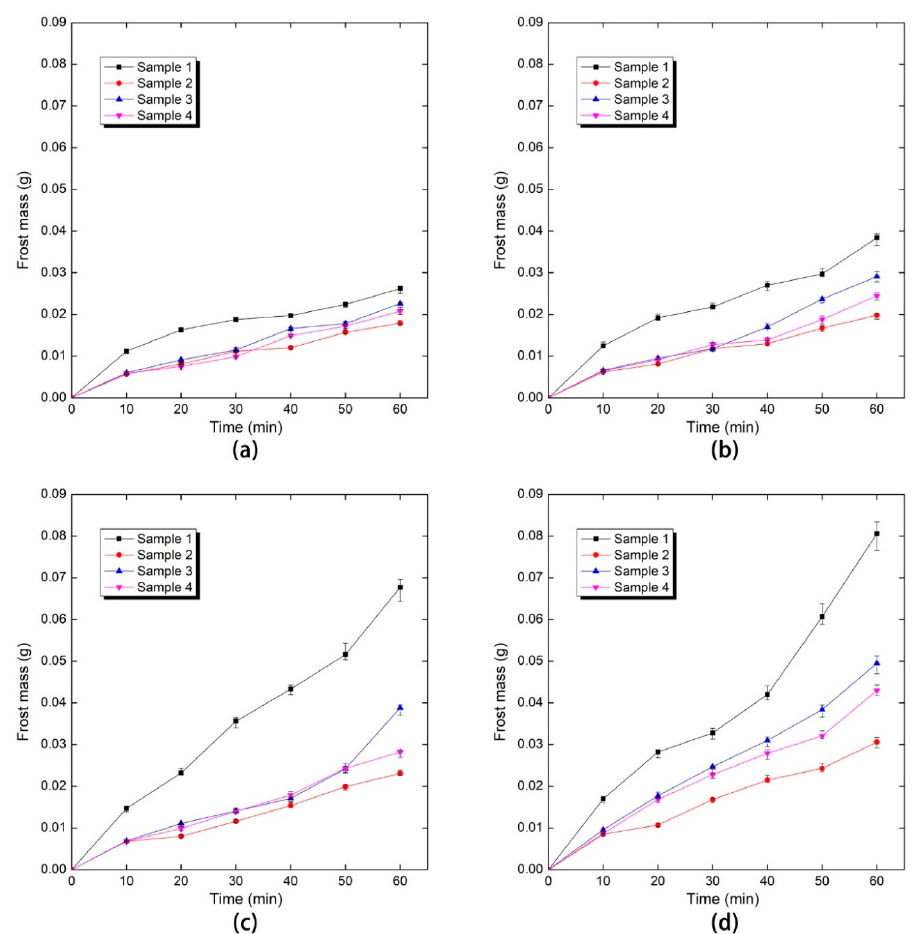
Figure 5. The fr ost mass of the different aluminum sheets under different surface temperatures; T a = 5 °C, φ = 60%, and T s = ( a ) − 5 °C; ( b ) − 10 °C; ( c ) − 15 °C; and ( d ) − 20